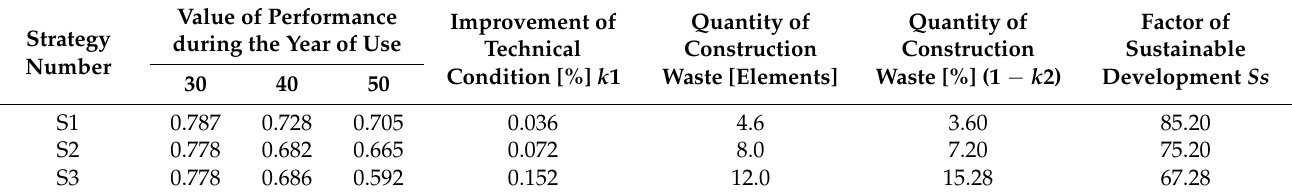
Table 3. Results of the comparative